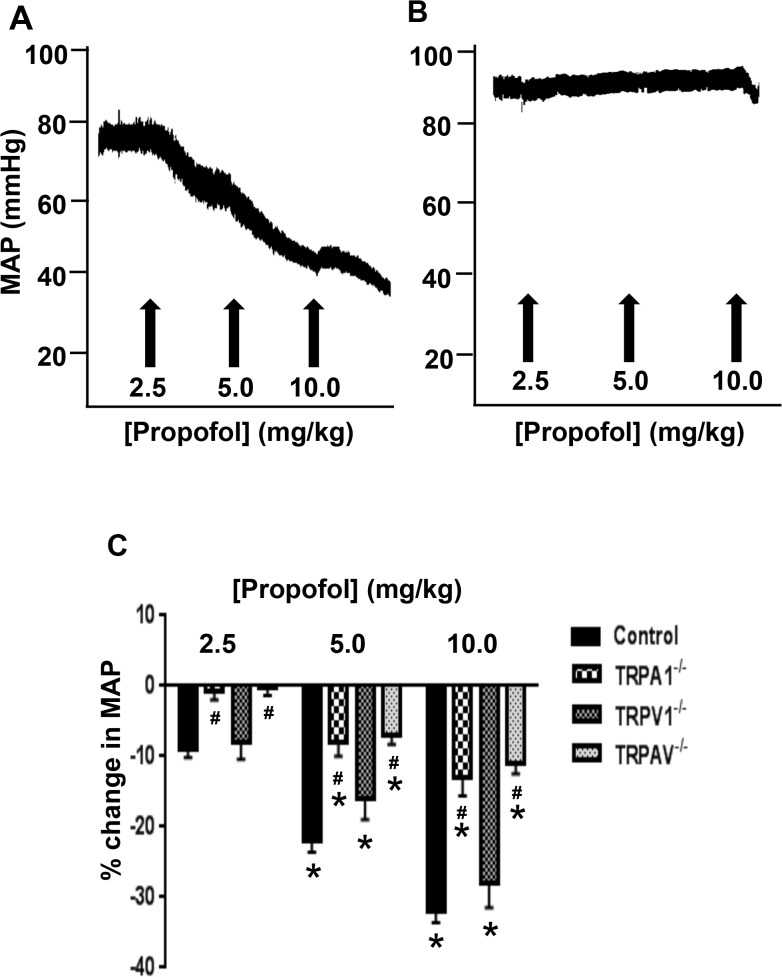
Effect of Propofol on MAP.Panel A and B shows representative traces depicting the effect of propofol on MAP in control and TRPA1-/- mice. Panel C depicts summarized data depicting the effect of propofol on MAP in control (n = 26), TRPA1-/- (n = 12), TRPV1-/- (n = 12) and TRPAV-/- mice (n = 12). Data are means ± SEM * = P<0.05 vs. baseline. # P<0.05 vs. control.